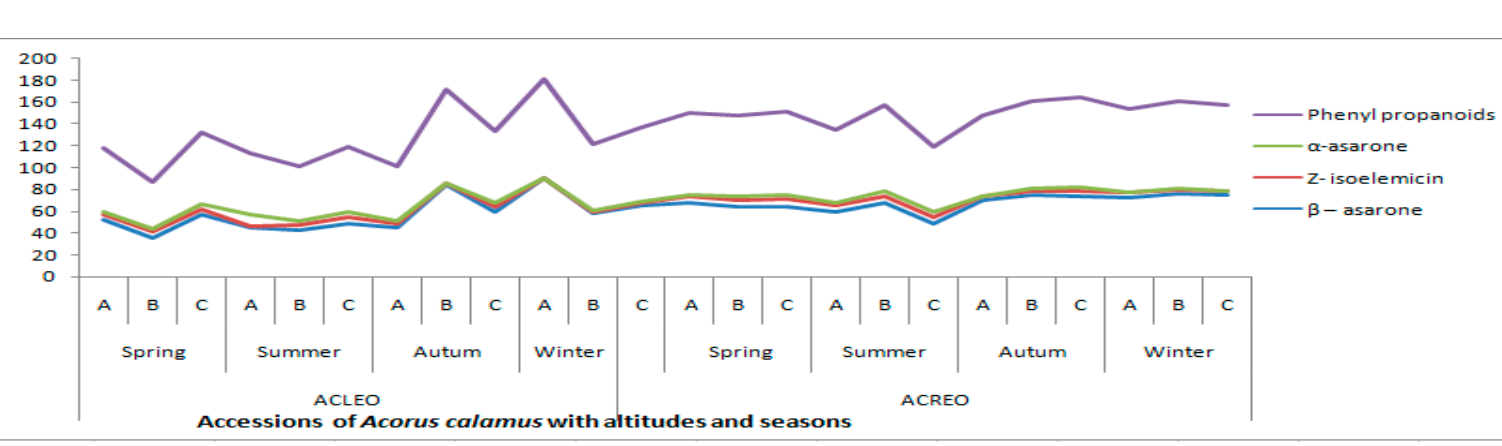
Figure 1. Phenylpropanoids in ACLEO and ACREO in different seasons from different altitudes.